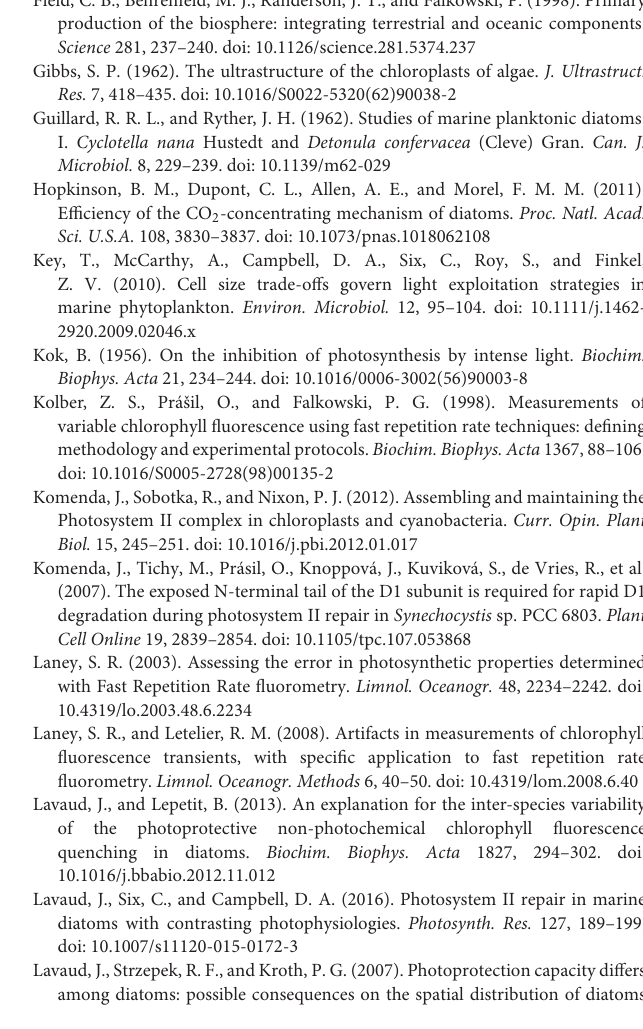
constant for accumulation of PsbD protein vs. rate constant for accumulation of PsbA for T. pseudonana (C) or T. punctigera (D) . Closed symbols are measures from dark periods; gray symbols from cultures under 75 µ mol photons m − 2 s − 1 ; open symbols from cultures under 300 µ mol photons m − 2 s − 1 . Dashed line